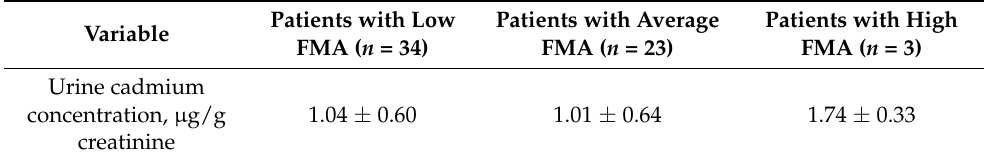
Table 7. Comparison of urine cadmium concentration in orthodontic patients with different FMAs ( n =